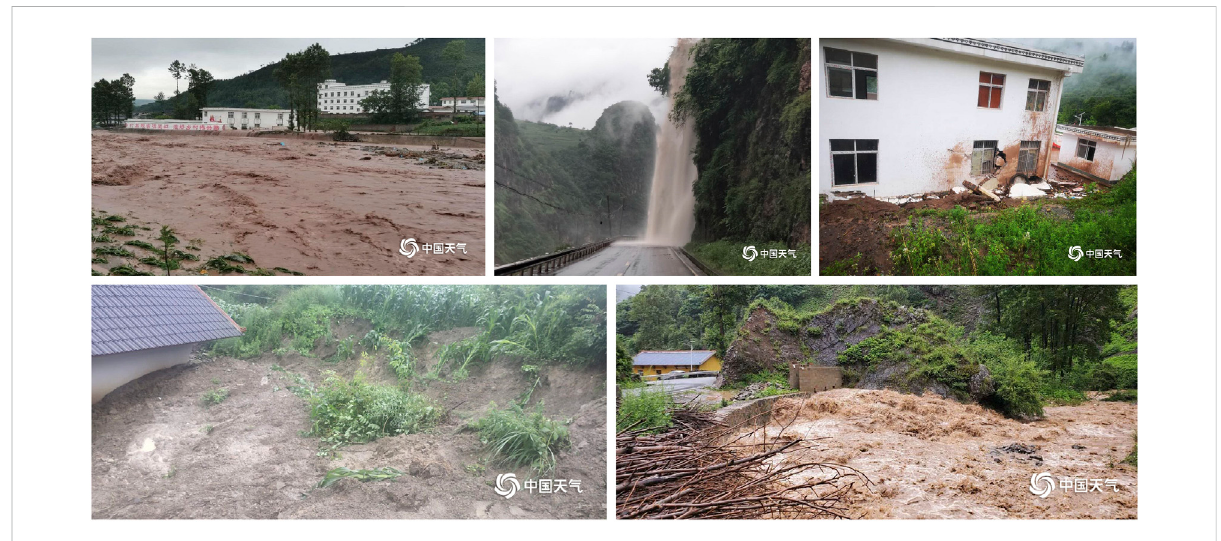
FIGURE 2 Geological disasters in the study area. (Photo source: China Weather, http://www.weather.com.cn/).